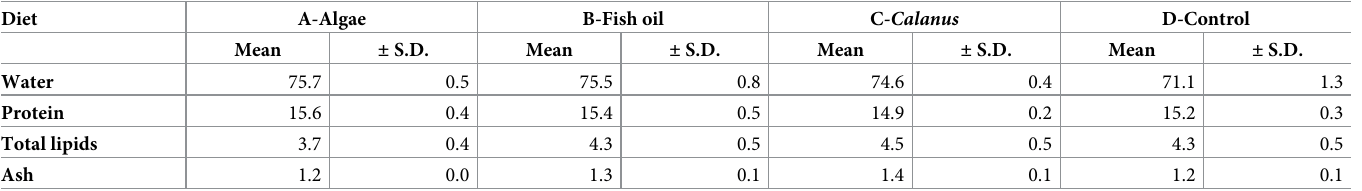
Table 7. Water, lipid and protein composition (% of wet weight) of Atlantic salmon ( Salmo salar L) juveniles fed diet A, B, C and D (n = 9 for each diet). Diet A-Algae B-Fish